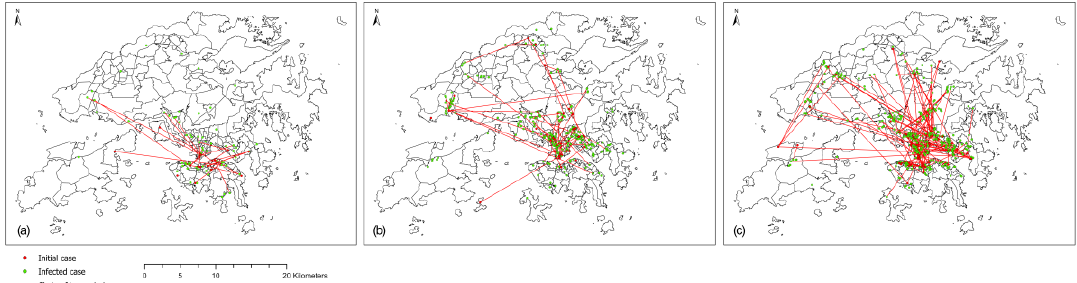
Figure 2. Flowchart of COVID-19 transmission chain reconstruction.